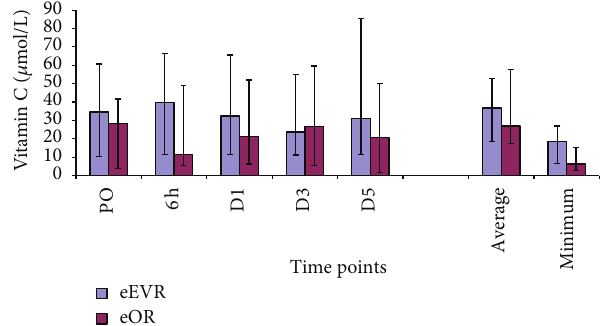
Figure 6: Plasma vitamin C levels expressed as median and